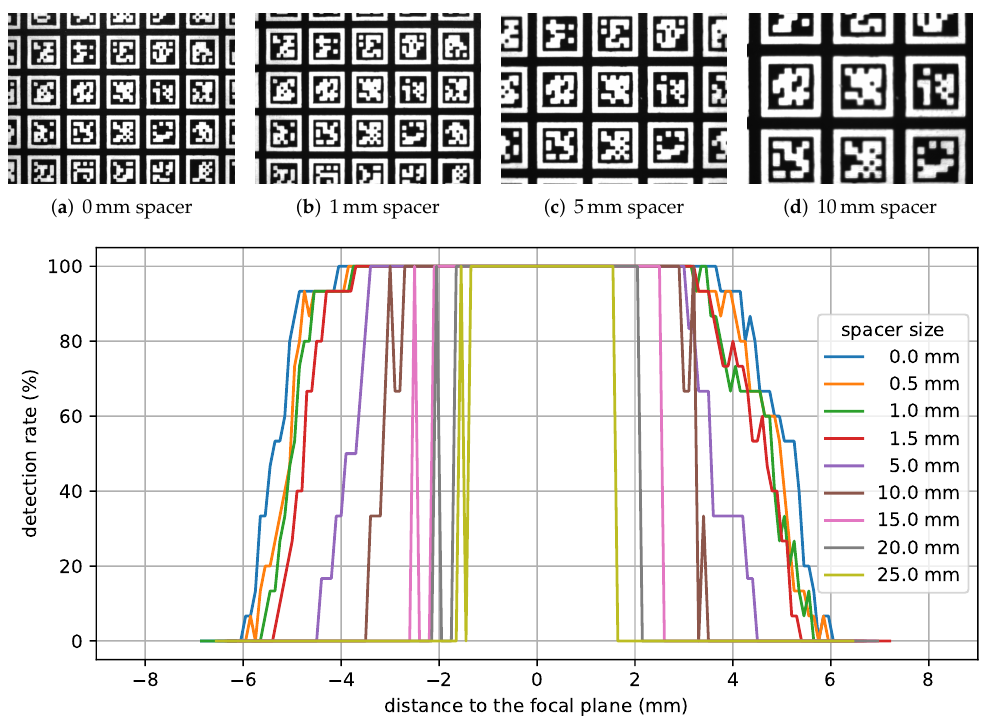
Figure 9. Spacer size and the corresponding fields of view in the focal plane: ( a ) 0mm, ( b ) 1mm, ( c ) 5mm, and ( d ) 10mm spacer. Influence of the spacer size on the detection rate of AprilTags. Due to the camera’s depth of field, AprilTags in the focal area are detected more accurately than AprilTags in the border area. The border area is the area with a distance to the focal plane where the detection rate starts to deteriorate but AprilTags are still detected. Consequently, the parallel mechanism’s pose is estimated to be less accurate in the border area than in the focal area. Figure 10 shows the estimated poses for a staircase motion in z -direction where AprilTags are detected in the border area as well as in the focal area. It can be noticed that the poses in the border area are significantly more noisy than in the focal area. Furthermore, not all AprilTags were detected (indicated by missing measurements).